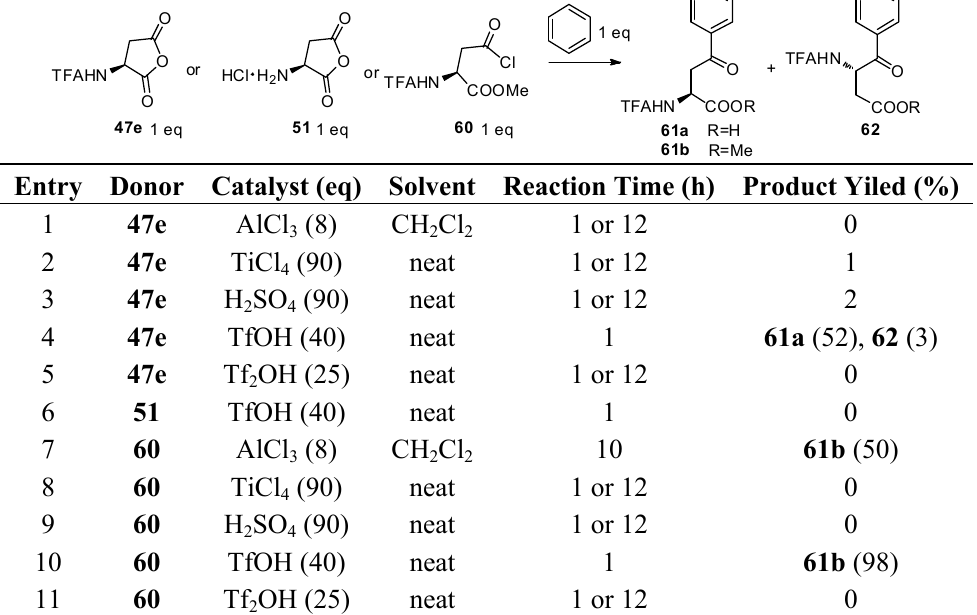
Table 2. Friedel–Crafts reaction of anhydrides and stoichiometric amounts of benzene. OO ClO OO OTFAHN COOMeTFAHN